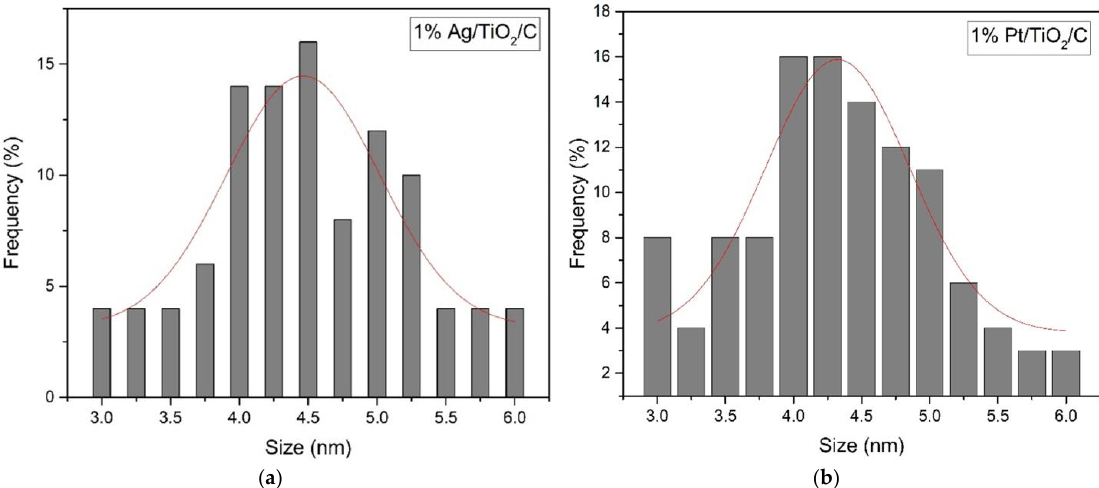
Figure 4. Particle size for 1% Ag/TiO 2 /C ( a ) and 1% Pt/TiO 2 /C ( b ).